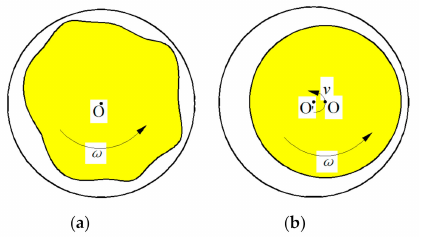
Figure 2. Dynamic non-uniform tip clearance. ( a ) Non-uniform blade height; ( b ) whirling rotor